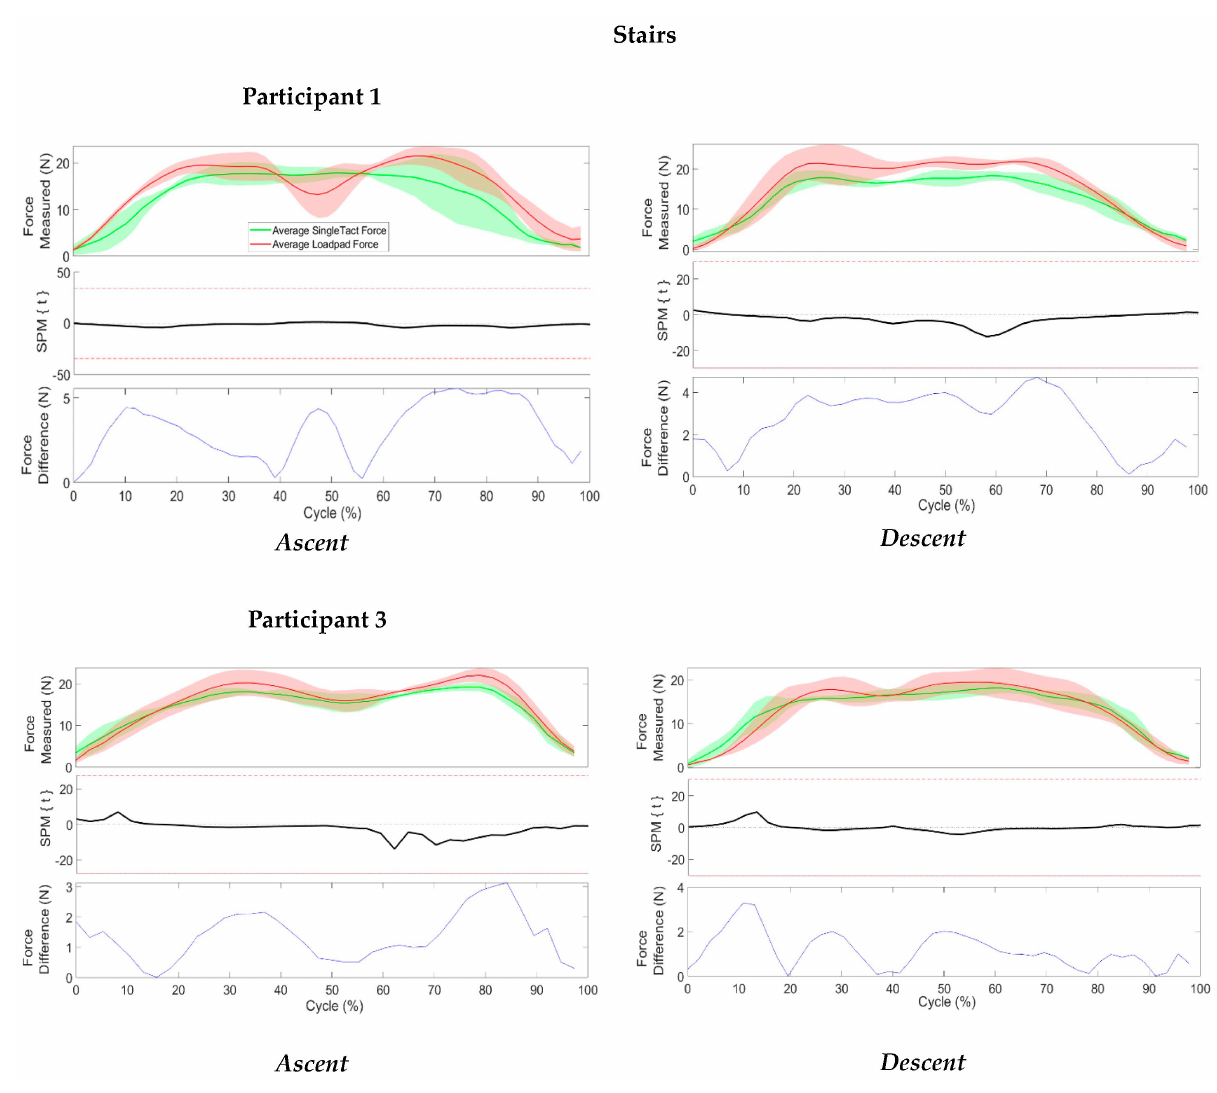
Figure 9. SPM (Mean and SD) of force measurements for SingleTact and Loadpad at the distal end of the residual limb during the ascent and descent of stairs: (green = measured average force of SingleTact, red = measured average force of Loadpad) .